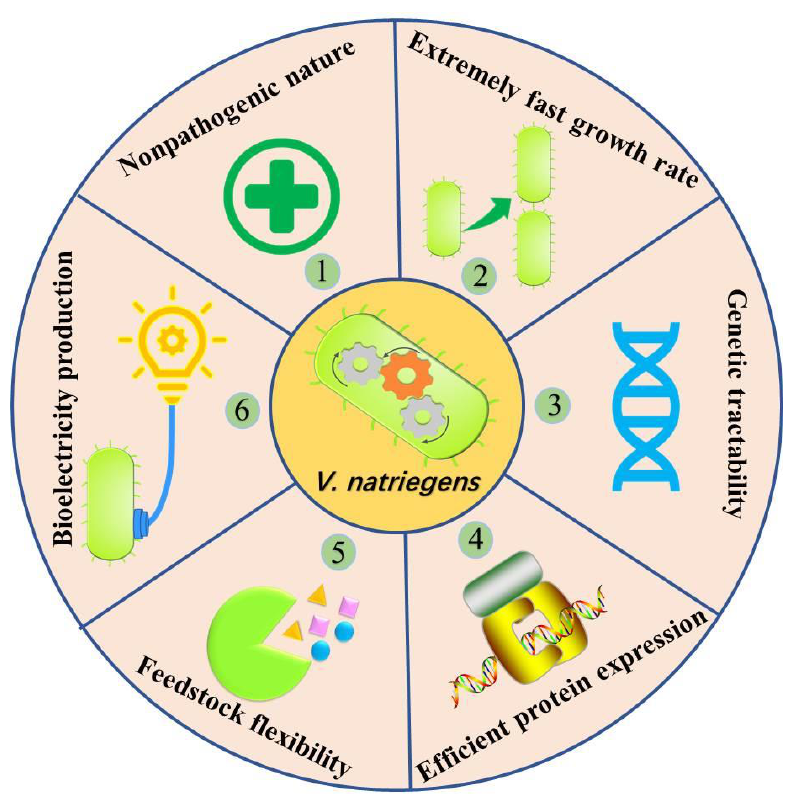
Figure 1. The inherent benefits of V. natriegens . Numbers 1 to 5 show the previously reported inherent benefits, and number 6 is the bioelectric production which is the inherent benefit described in this study.